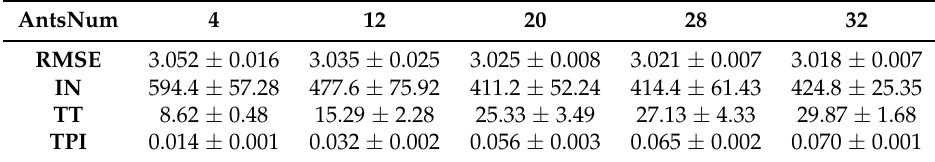
Table 12. Comparison of different AntsNum in MG-ACOEE on the parallel performance for Cuprite data.